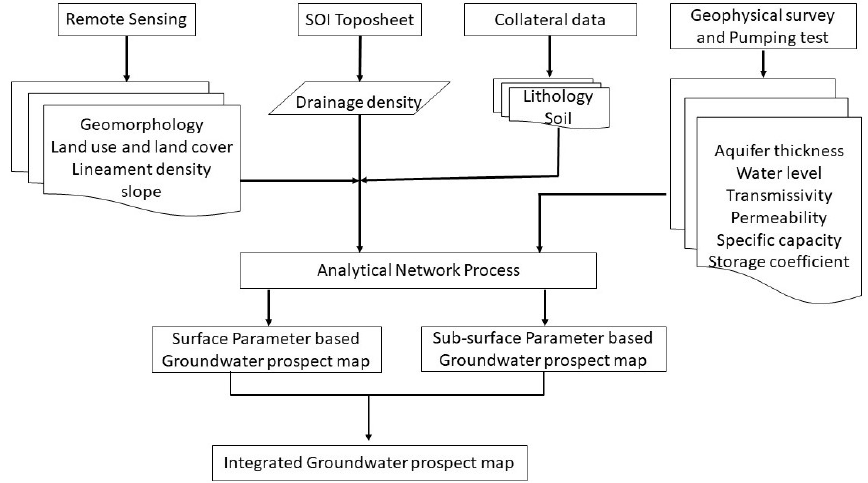
Figure 2. Flow chart showing methodology.